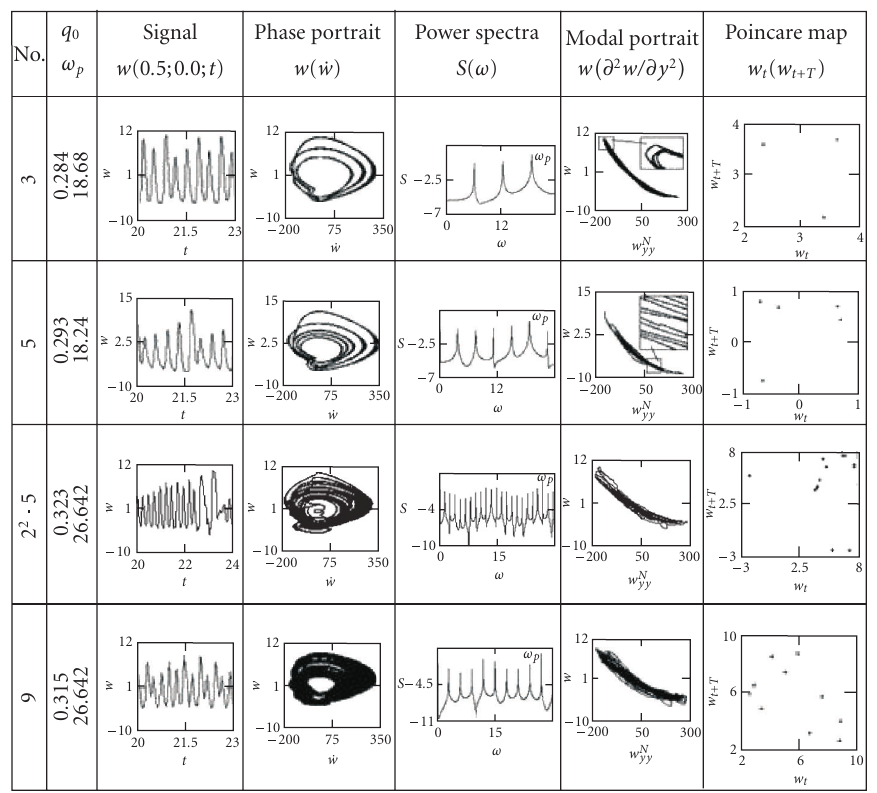
Table 3.1. Indicators of